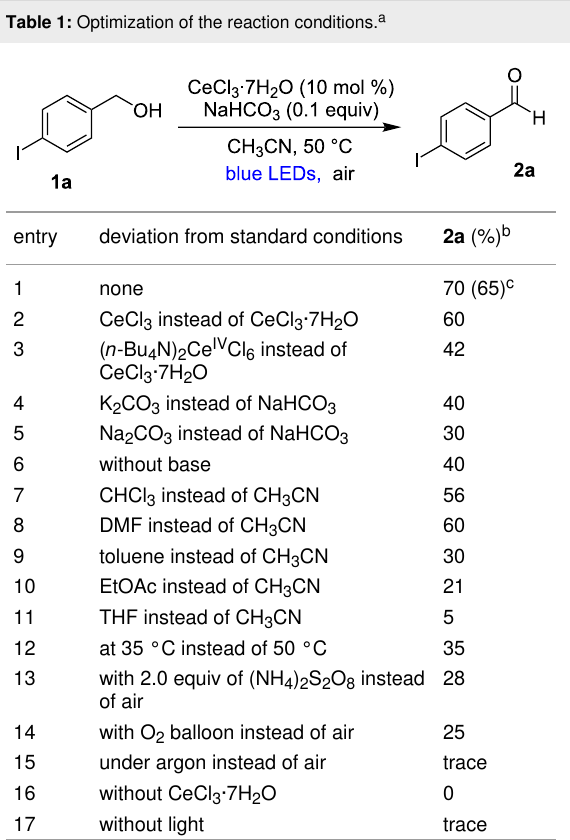
Table 1: Optimization of the reaction conditions.